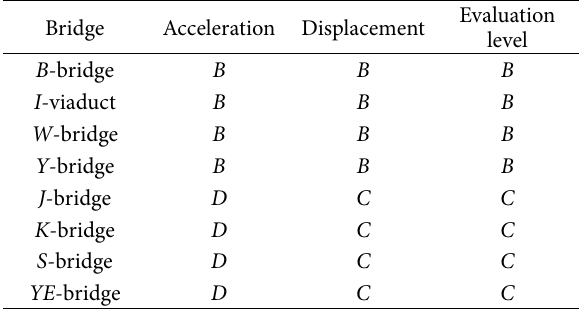
Table 3. Evaluation of serviceability of bridge